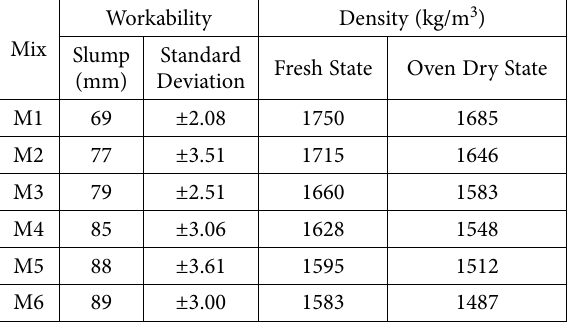
Table 4. Workability and Density of the Lightweight Concrete